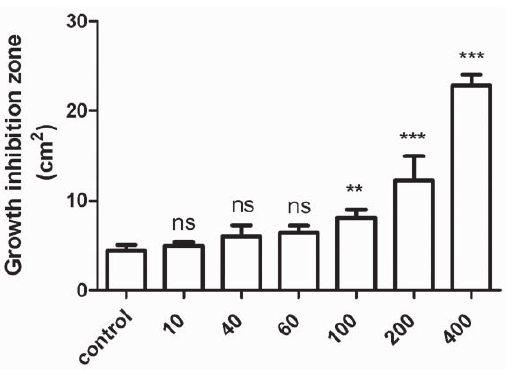
Figure 2. Minimal tellurite concentration causing a cefotaxime- potentiating effect in E. coli . Inhibition growth zones were determined as described in Methods using LB plates amended with the indicated sub lethal tellurite concentrations (nM).